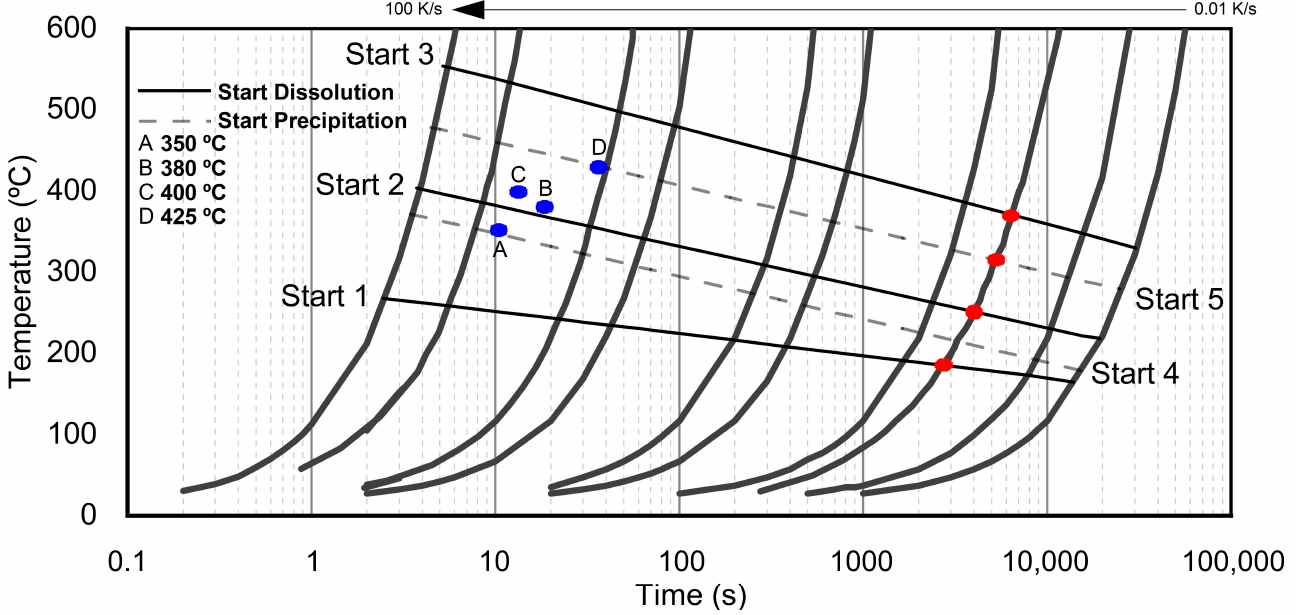
Figure 6. Localization of heat treatment maximum temperatures according to the predominant transformation phase in the continuous heating dissolution diagram.